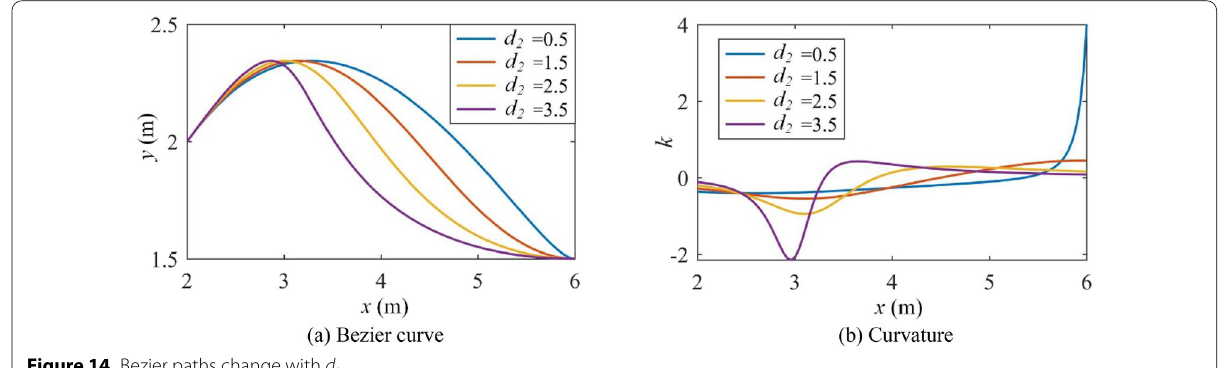
Figure 14 Bezier paths change with d